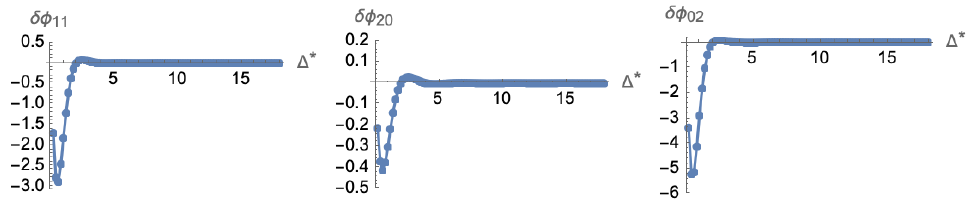
Figure 7: Estimate of ∆ > ∆ ∗ contributions to φ considered is